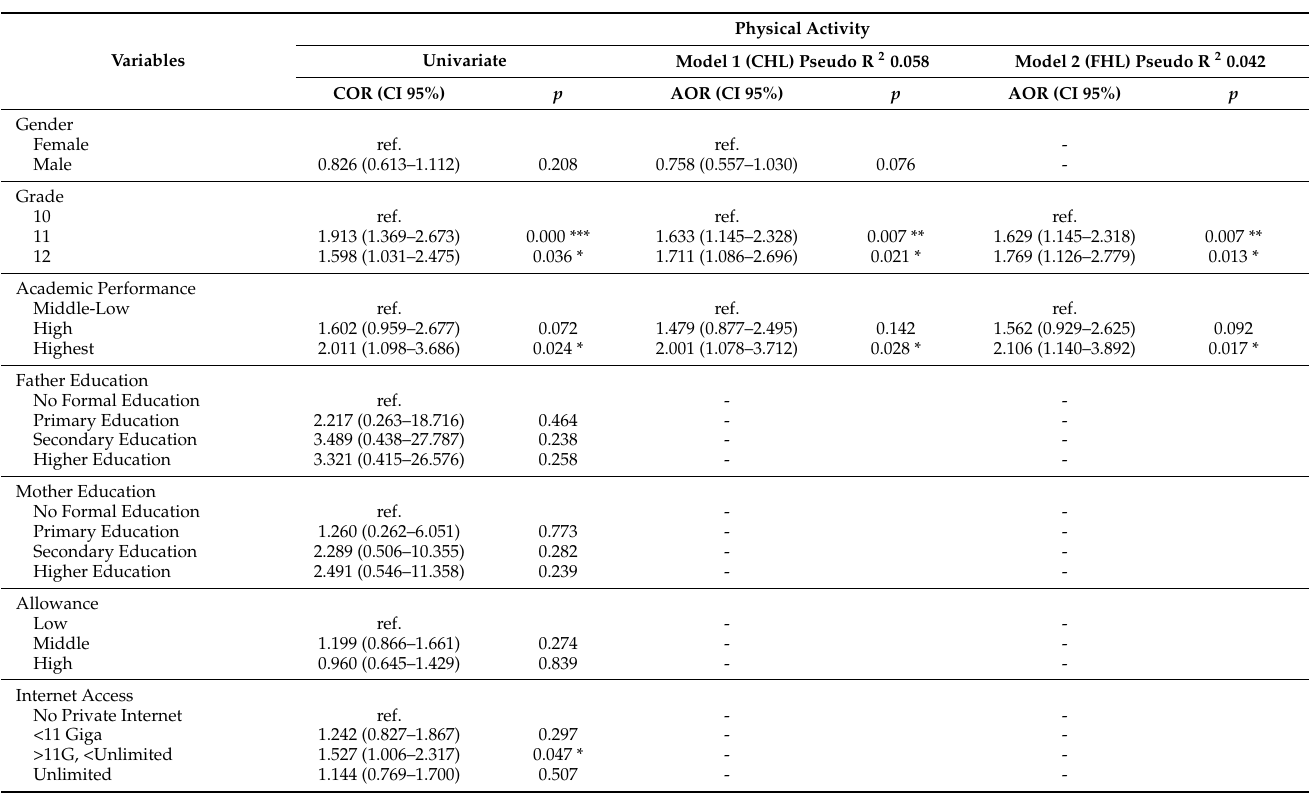
Table 5. Univariate and multivariate logistic regression of physical activity with socioeconomic factors in the CHL and FHL